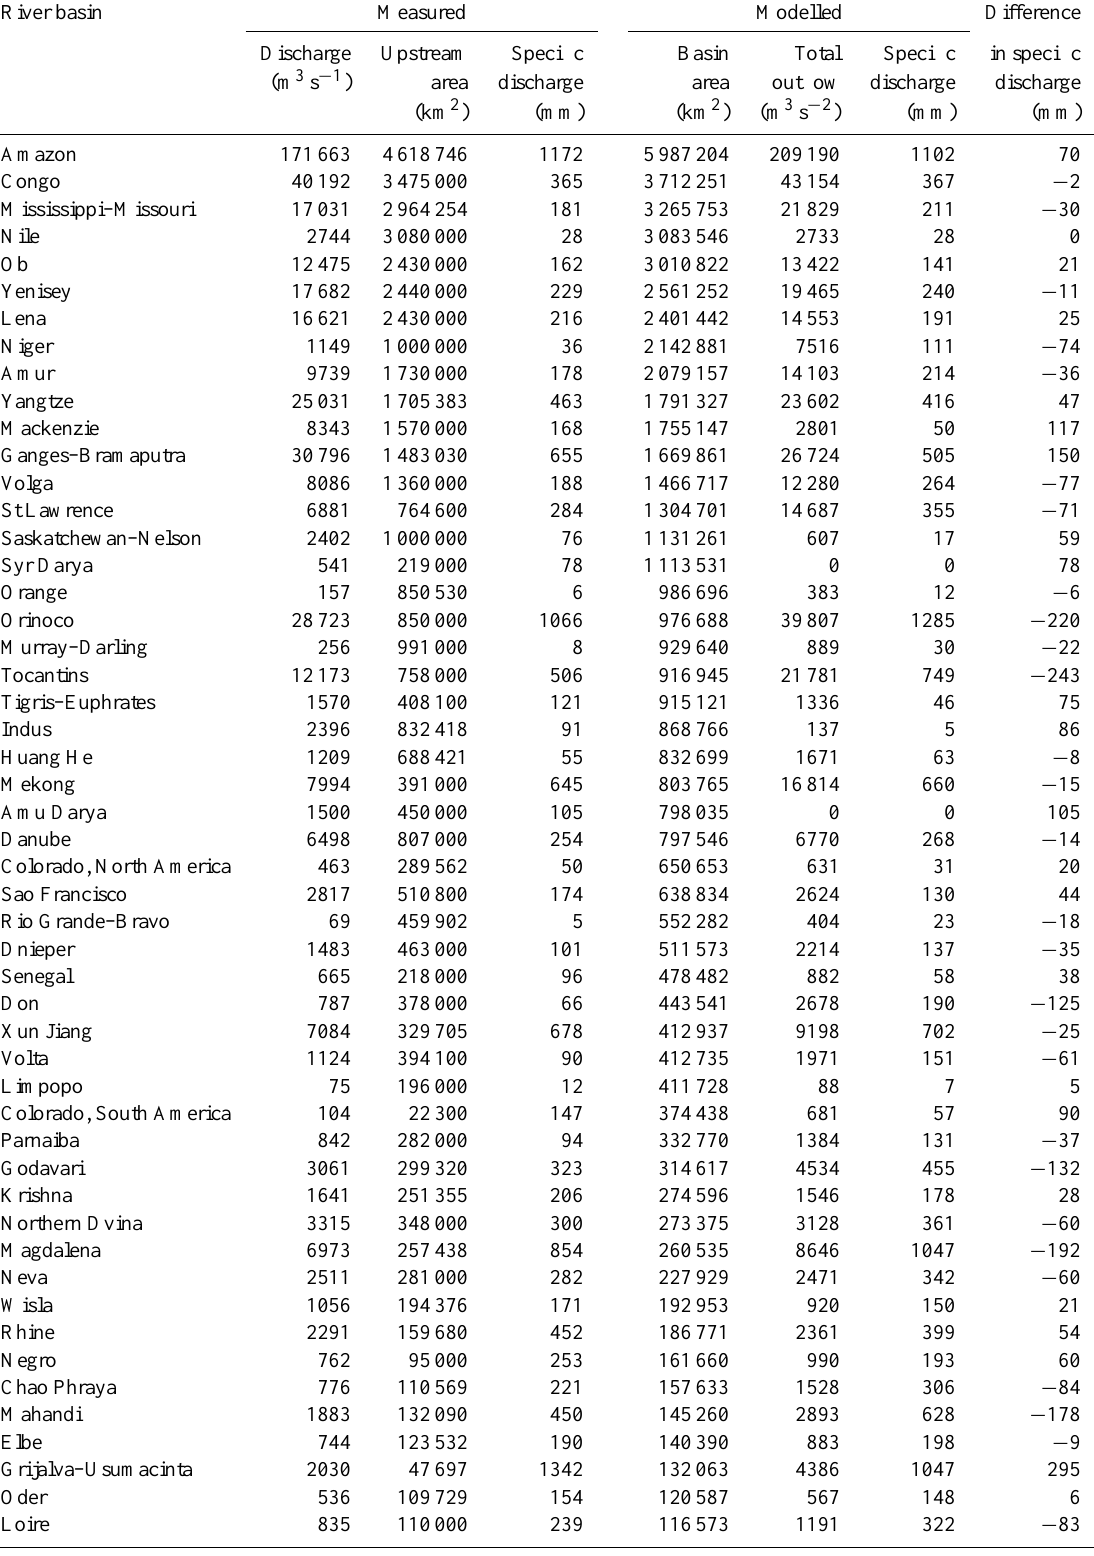
Table 5. Validation results per river